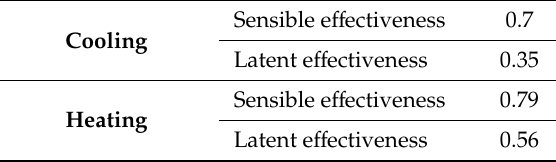
Table 9. E ff ectiveness of energy recovery ventilation